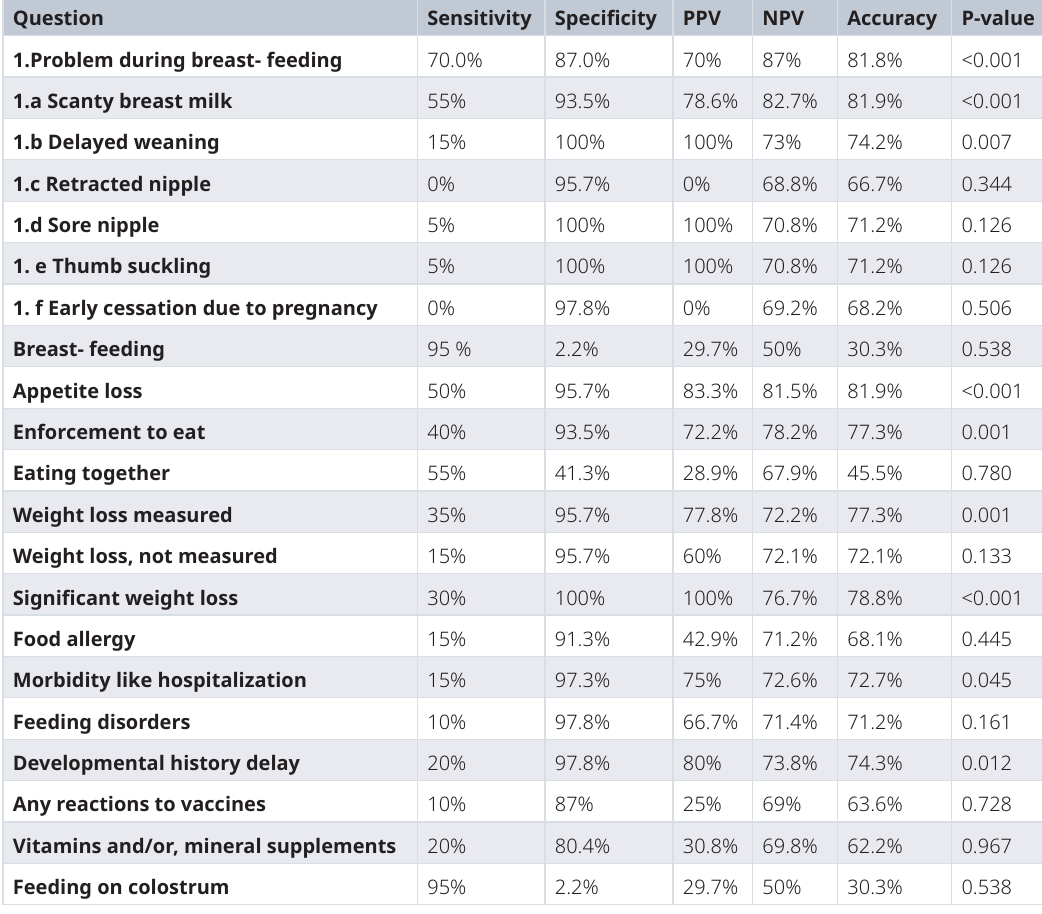
Table 2. Comparison between the screening questions and the subjective global assessment in the less than 2 years group.